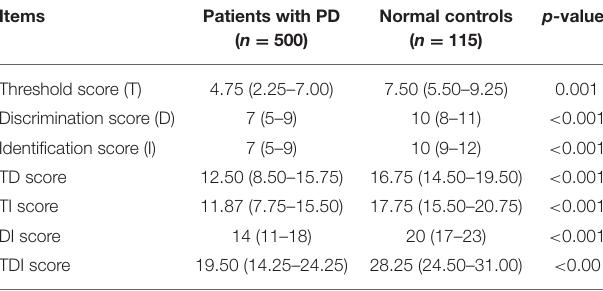
TABLE 2 | Olfaction function in patients with Parkinson’s disease (PD) and